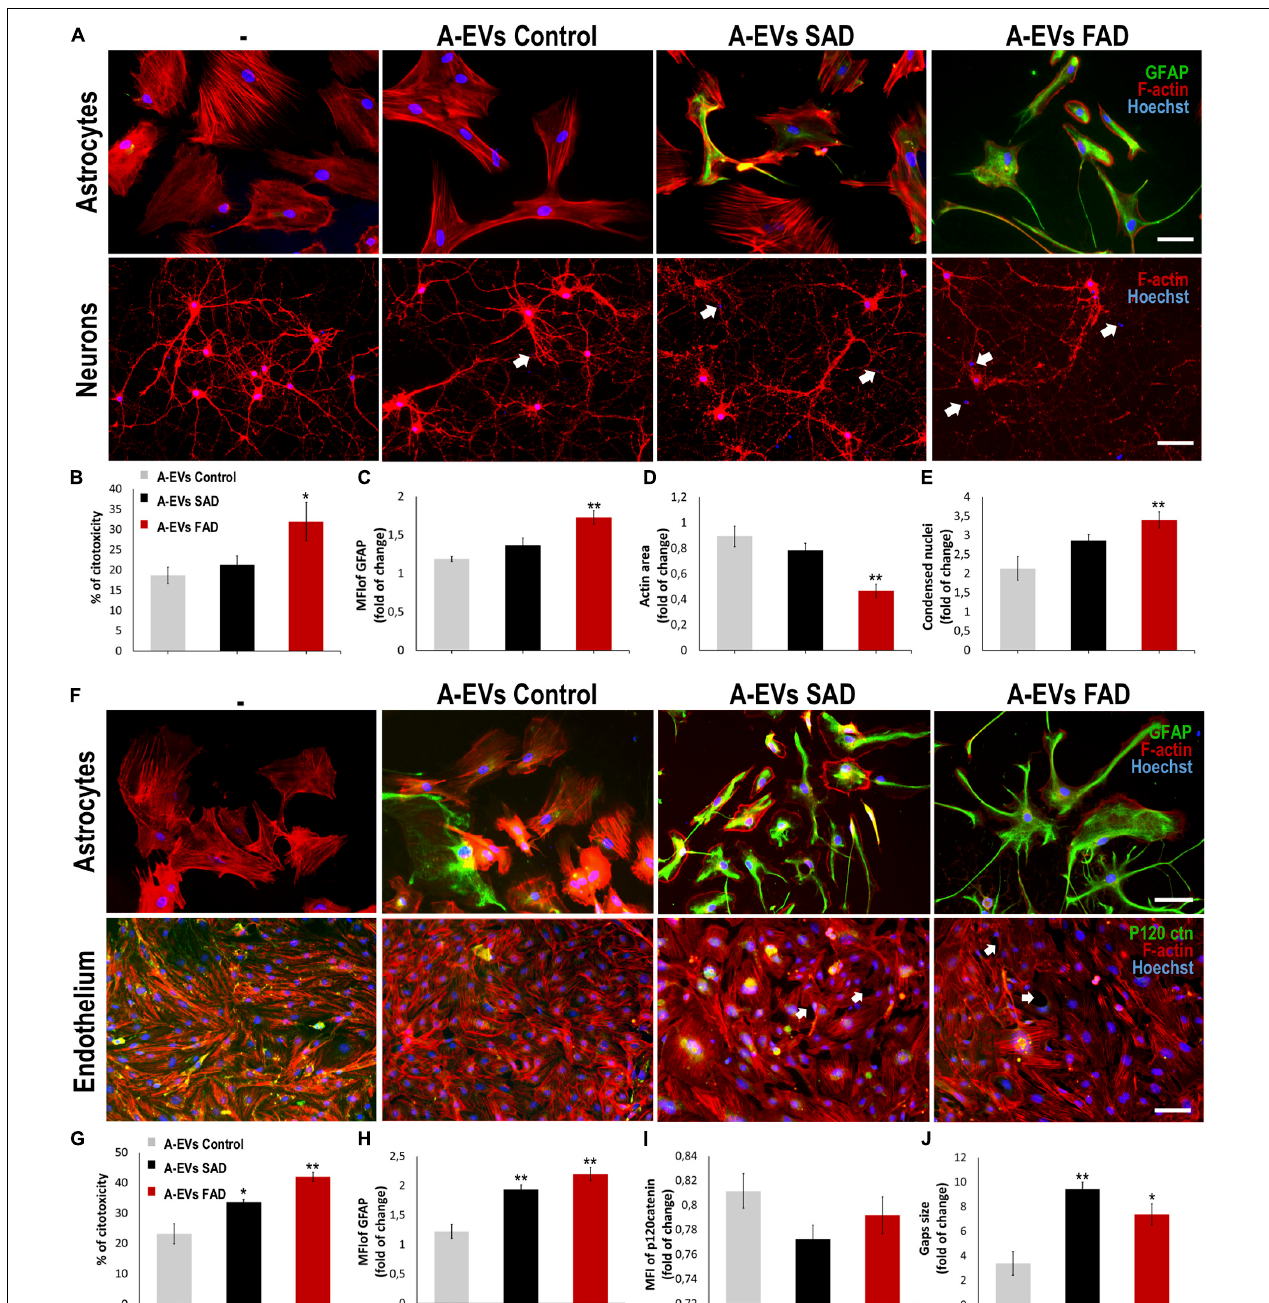
FIGURE 6 | AD A-EVs induce neuroglial and astrocyte-endothelial damage. (A) Morphological characterization showing the following: Astrocytes: F-actin in red, GFAP in green and nuclei in blue. Magnification × 20, scale bar 100 µ m. Neurons: F-actin in red and nuclei were stained with Hoechst (blue). Magnification × 20, scale bar 100 µ m. White arrows indicated condensed nuclei in neurons. (B) The cytotoxicity of co-culture astrocytes-neurons is expressed as the percentage of LDH released from cells 24 h after CNT-, SAD-, FAD A-EVs. (C-D) Fold change data calculated by dividing the values by the value obtained from cells with no EV treatment. (C) Fold change of GFAP intensity (MFI) of astrocyte, (D) fold change of the percentages of F-actin per field of neurons, and (E) fold change of the percentage of condensed nuclei of neurons treated with CNT-, SAD-, FAD A-EVs. Representative data from CNT, n = 3; SAD, n = 3; FAD, n = 3. Data was plotted as means and SEM. One-way ANOVA, Tukey’s multiple comparison test. ∗ Indicates p < 0.05; ∗∗ indicates p < 0.01. (F) Morphological characterization of astrocytes: F-actin in red, GFAP cytoskeleton in green and nuclei in blue. Magnification × 20, scale bar 100 µ m. Endothelia: F-actin in red, p120catenin in green and nuclei in blue. Magnification × 20, scale bar 100 µ m. White arrows indicate gaps in endothelial cells. (G) The cytotoxicity of astrocytes-endothelial co-culture expressed as the percentage of LDH released from cells 24 h after CNT-, SAD-, FAD A-EVs. (H) Fold change of GFAP and (I) p120 catenin intensity (MFI) of astrocytes and endothelia treated with CNT-, SAD-, FAD A-EVs, respectively. (J) Fold change of gap size of endothelia treated with CNT-, SAD-, FAD-EVs. CNT, n = 3; SAD, n = 3; FAD, n = 3. Data was plotted as means and SEM. One-way ANOVA, Tukey’s multiple comparison test. ∗ Indicates p < 0.05; ∗∗ indicates p < 0.01.